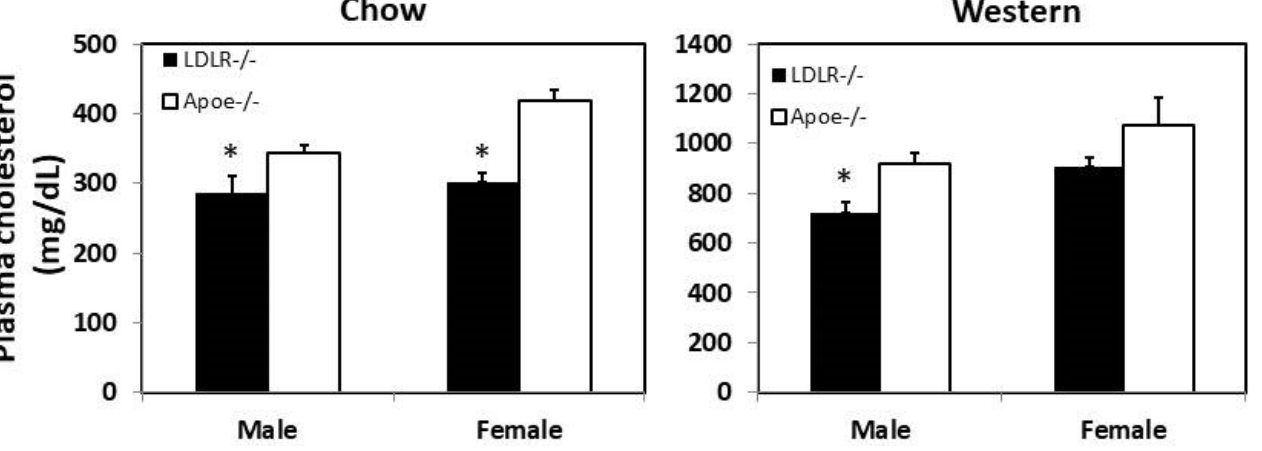
Figure 1. Fasting plasma levels of total cholesterol in male and female C3H- Apoe -/- and C3H- Ldlr -/- mice when fed a chow (left panel) or Western diet (right panel). Results are means ± SE of 4 to 29 mice per group. * p < 0.05 vs. Apoe -/- mice